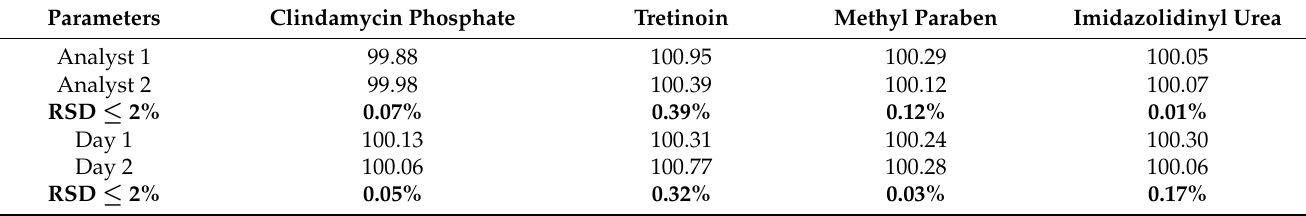
Table 3. Intermediate precision data for the determination of the studied